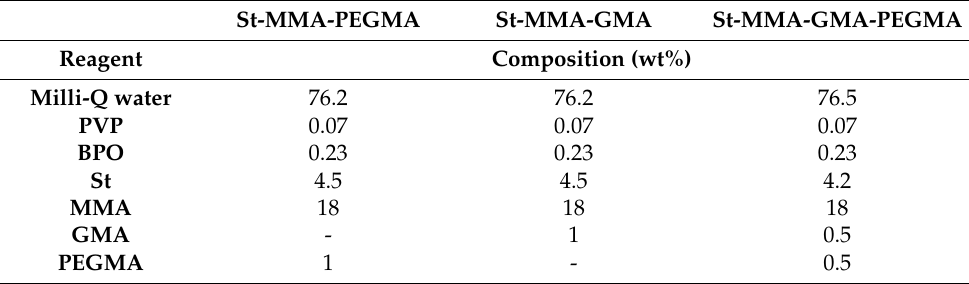
Table 2. Reaction recipe for the synthesis of functionalized St-MMA-based particles. St-MMA-PEGMA St-MMA-GMA St-MMA-GMA-PEGMA Reagent Composition (wt%) Milli-Q